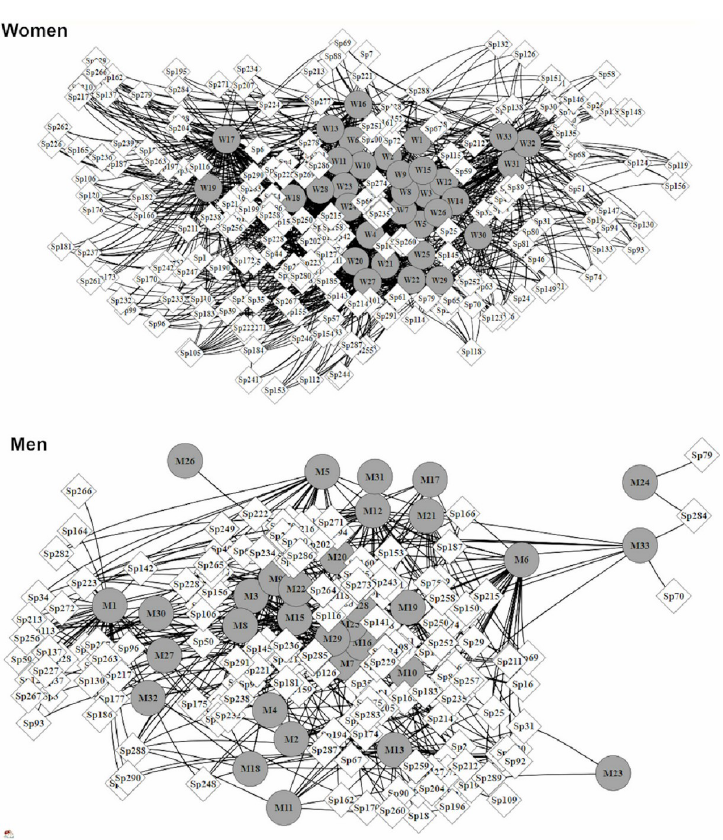
Fig 4. Socio-ecological networks among women and men illustrating the structure of traditional ecological knowledge on useful plants. Circles indicate participants (33 women and 33 men), while diamonds indicate each known plant species (n = 291). For plant species names see S1